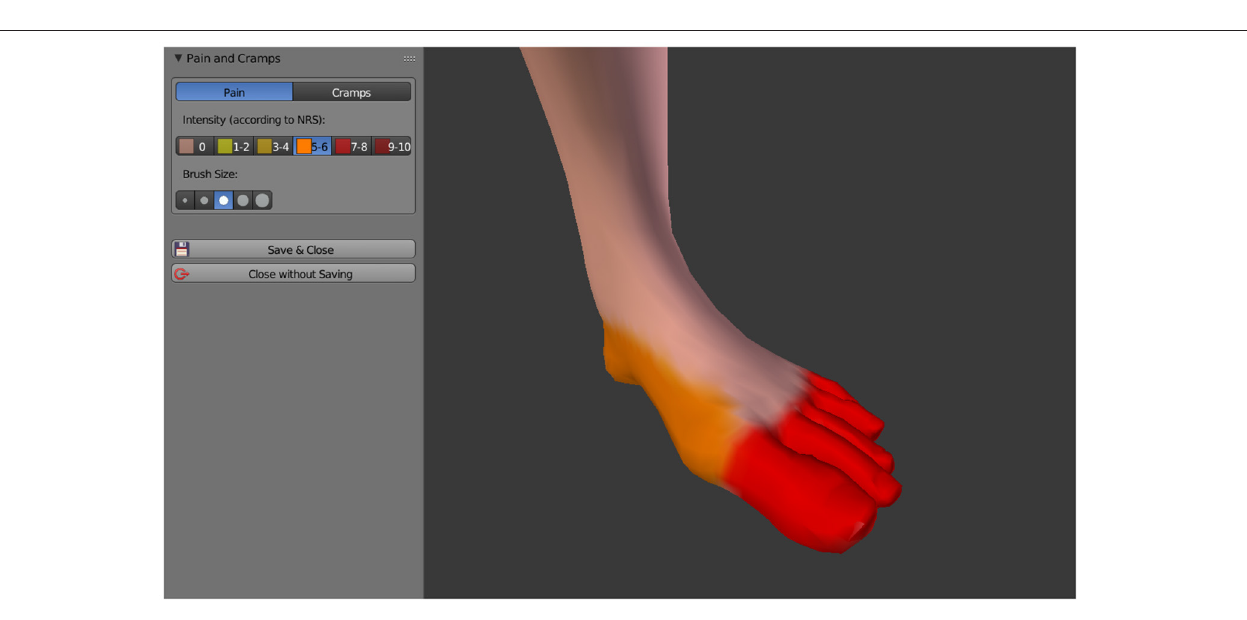
FIGURE 3 | Pain drawn directly onto the 3D avatar in different